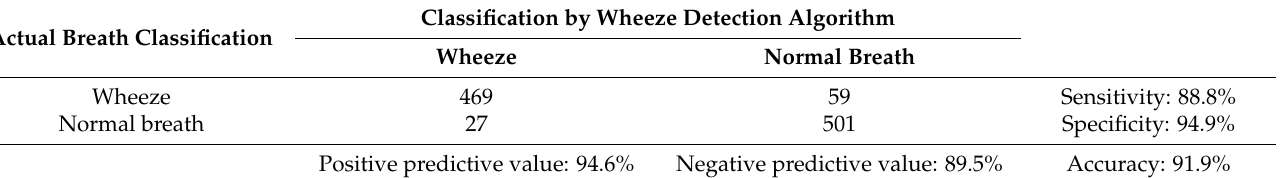
Table 3. Performance of wheeze detection